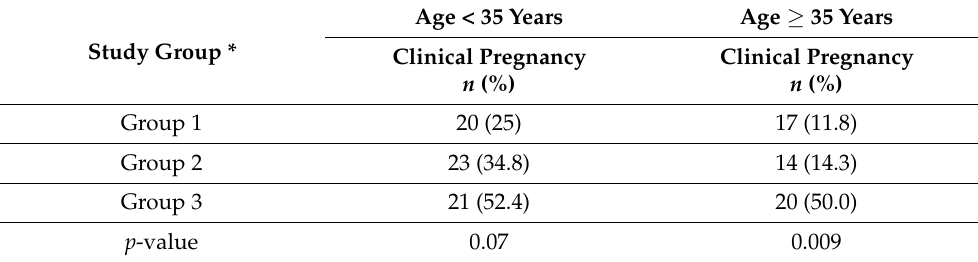
Table 3. Clinical pregnancy rate according to age at oocyte retrieval.